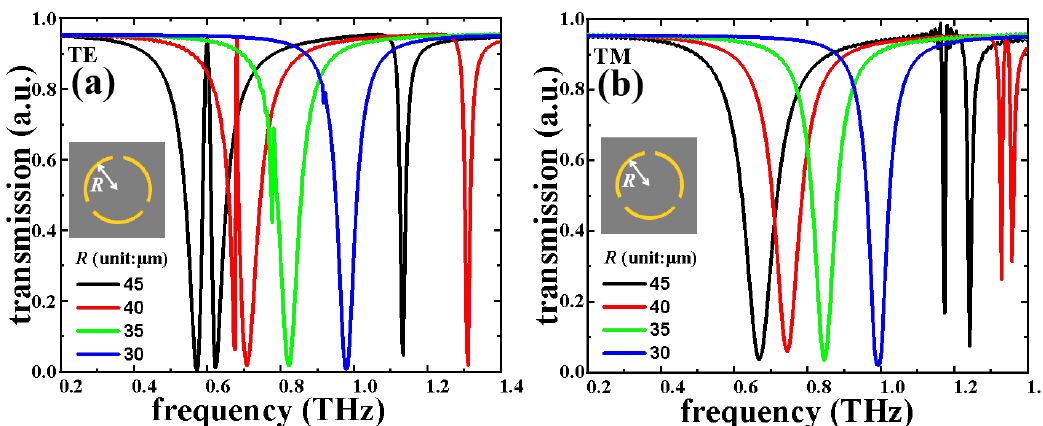
Figure 4. Electromagnetic responses of eSRR by changing the R parameter in ( a ) TE and ( b ) TM modes.